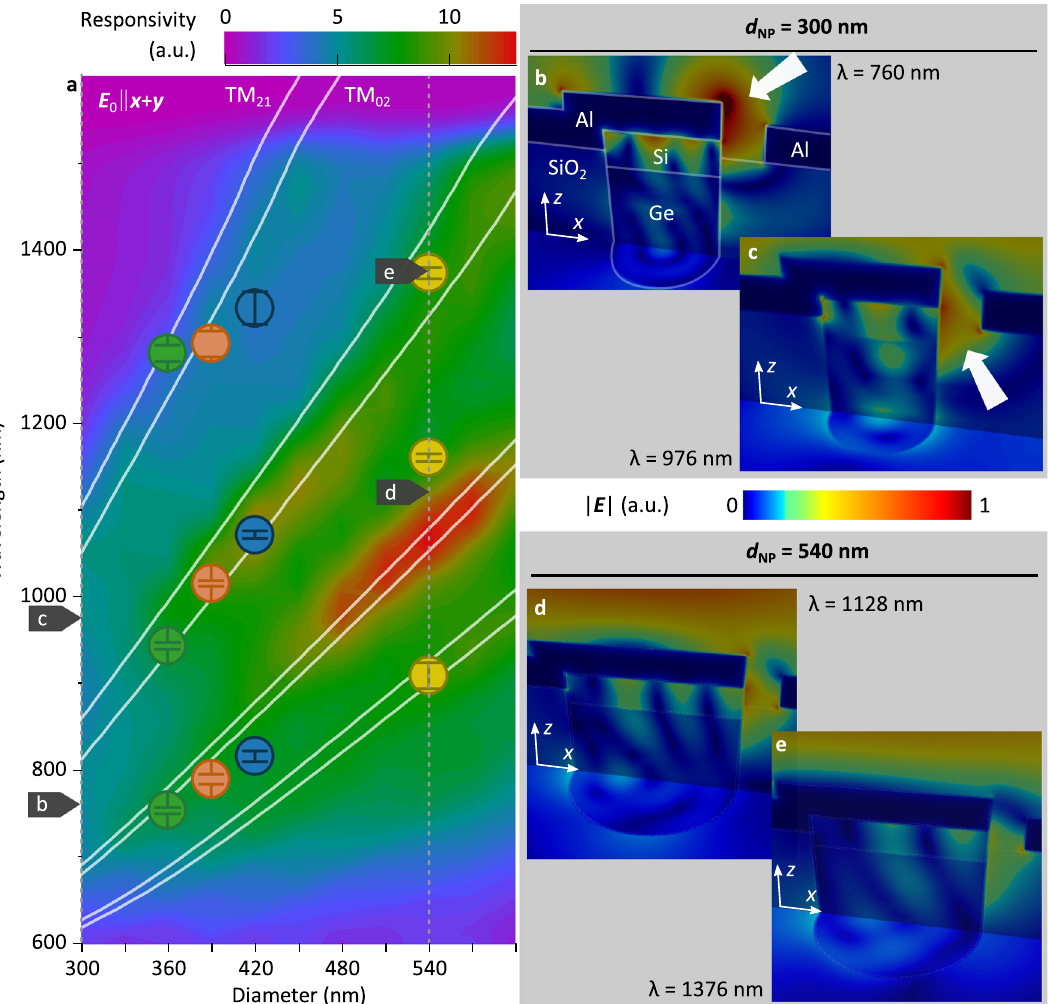
Figure 3. ( a ) Simulated spectral responsivity as a function of the NP diameter d NP for a complete device as shown in Fig. 1. The overlay shows the photonic modes as described by Eq. 1. The points indicate the maxima of the Gaussian functions used to fit the measured responsivities shown in Fig. 5. The orientation of the incident field was chosen to be E 0 ‖ ( x + y ). ( b )–( e ) Cross-sectional images of the absolute value of the electric field distribution inside NP-PDs with d NP = 300 nm at incident wavelengths of λ = 760 nm ( b ) and λ = 976 nm ( c ) (corresponding to absorption maxima, see Fig. 6a for n = 1.0) and NP-PDs with d NP = 540 nm at λ = 1128 nm ( d ) and λ = 1376 nm ( e ). The orientation of the incident field for ( b )-( e ) is E 0 ‖ x . The horizontal plane in ( b )–( e ) is approximately 250 nm below the top Si-Ge